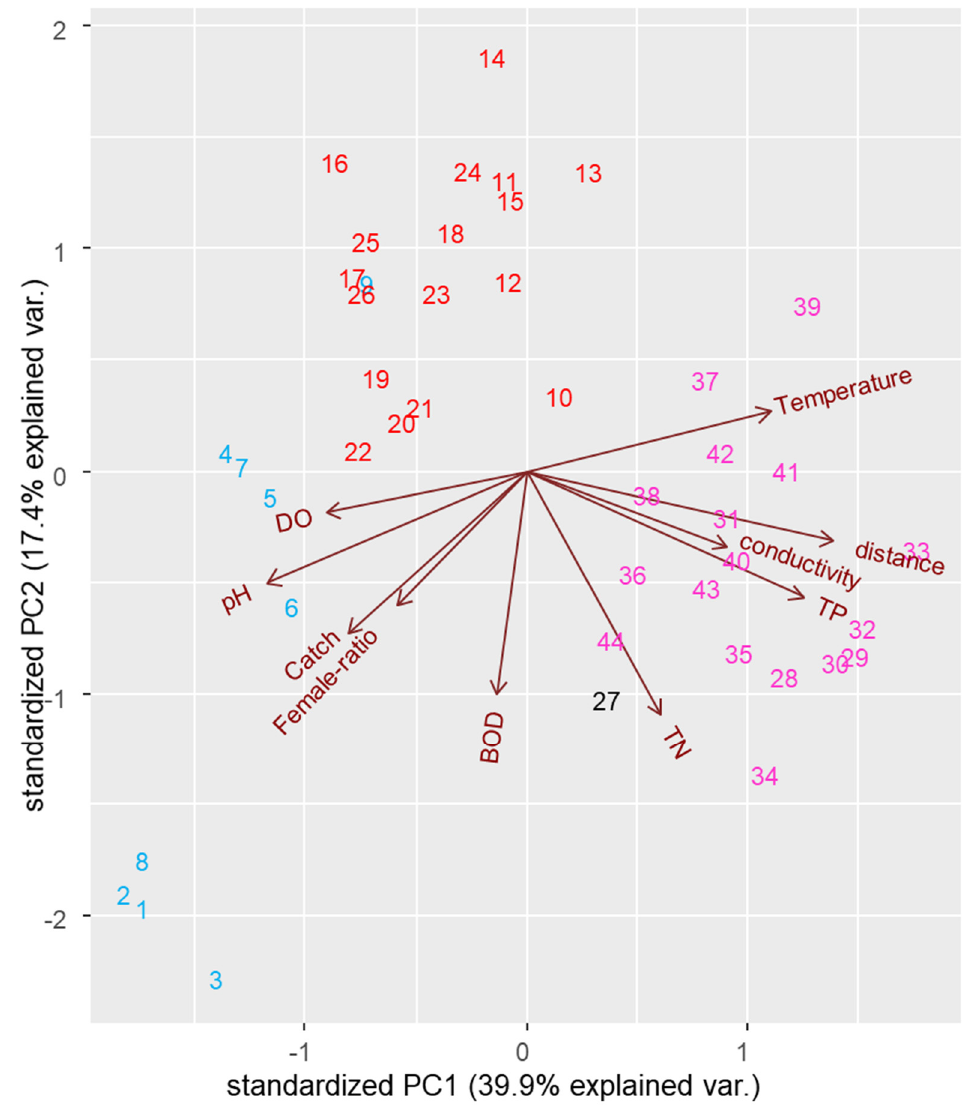
Figure 4. Principal component analysis (PCA) of ten variables (catch, female ratio, dissolved oxygen (DO), pH, biological oxygen demand (BOD), total nitrogen (TN), total phosphorus (TP), conductivity, distance, and temperature). The parameterized stations (1–9: R 1, 10–26: R 2, 27: R 3, 28–44: R 4) were gathered in accordance with three regions ( R 1, R 2, R 4). Table 2. The Pearson correlation coefficient and significance ( p ) between the variables. Significance at * p < 0.05 and ** p <